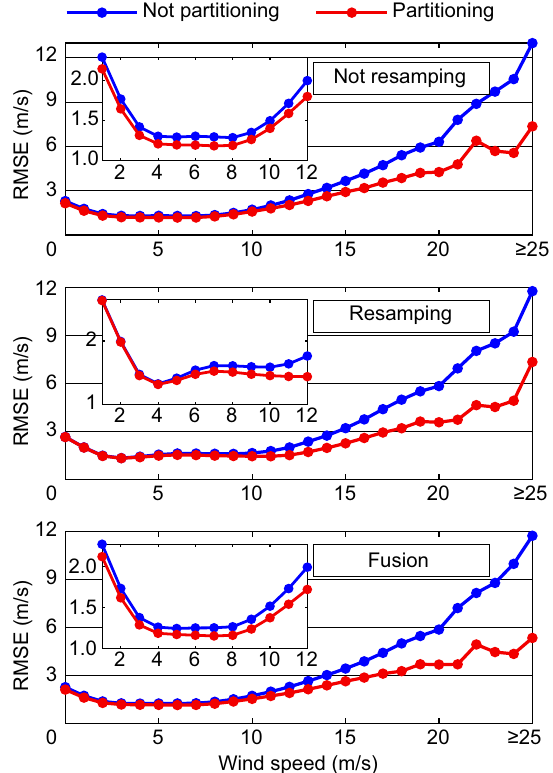
Fig. 10 Wind speed retrieval error curves of different